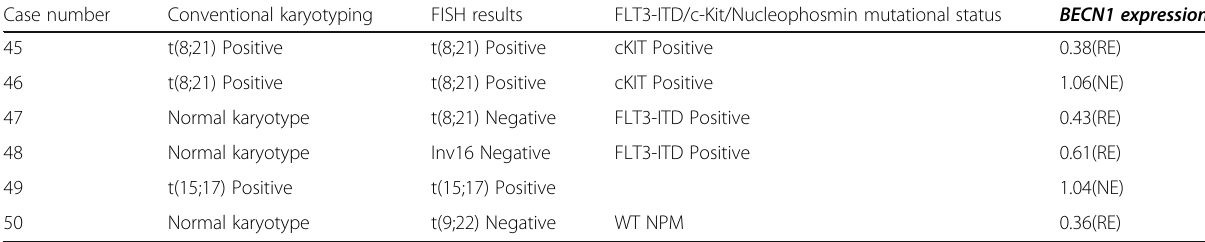
Table 2 Results of karyotyping, FISH analysis, mutational screening and BECN1 expression (Continued)